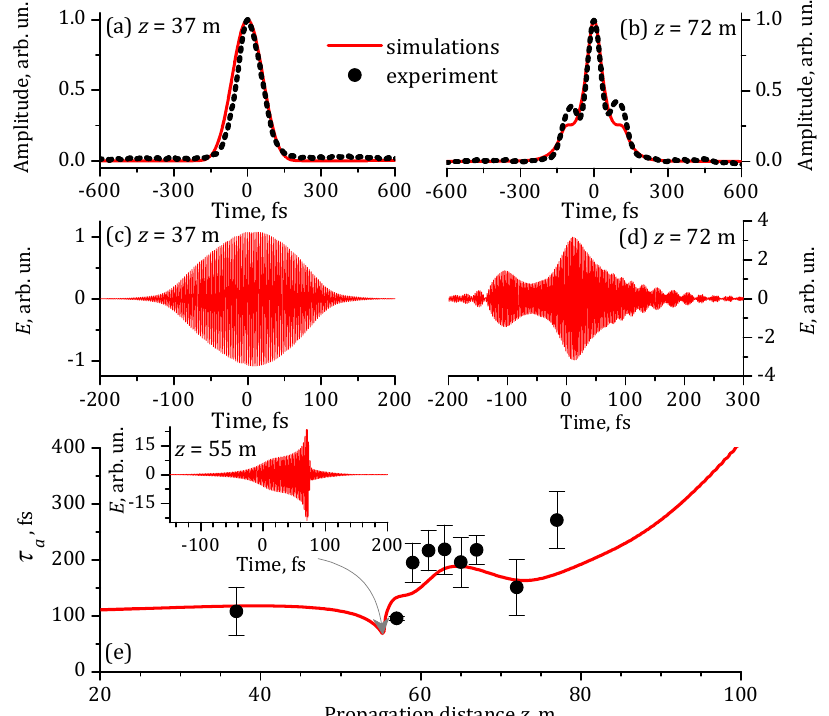
Figure 8. ( a , b ) Intensity autocorrelation functions obtained in the experiment (black dots) and numerical simulations (red curves); ( c , d ) simulated on-axis temporal distributions of the light field at several z . ( e ) Evolution of the doubled root-mean-squared width τ a of autocorrelation function with distance z obtained in the simulations (red line) and the experiment (black circles). Inset in ( e ) shows simulated on-axis temporal distribution of the light field at z = 55 m corresponding to the local minimum of the red curve in ( e